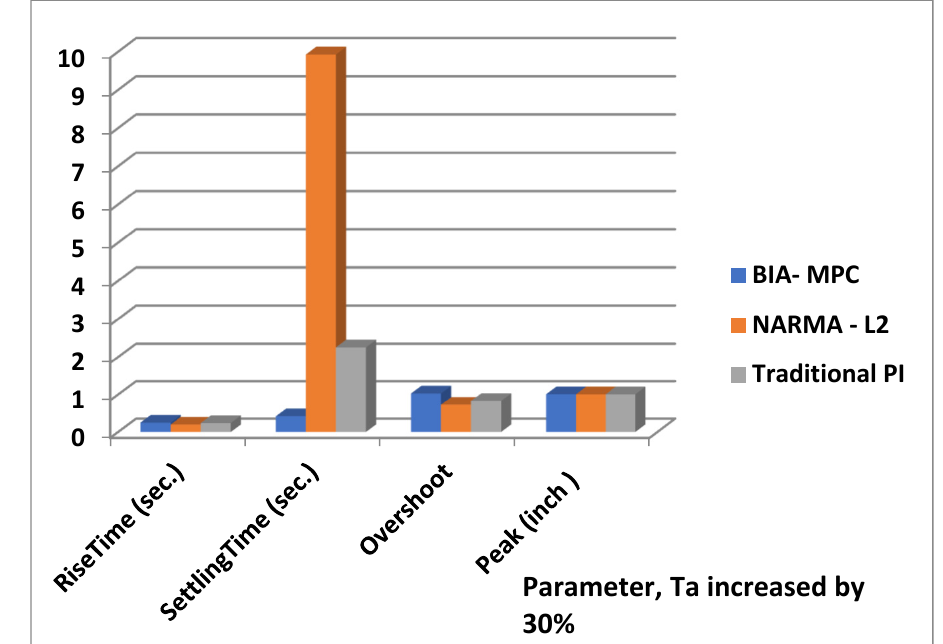
Figure 19. Chart of performance criteria in system perturbation by 20%.